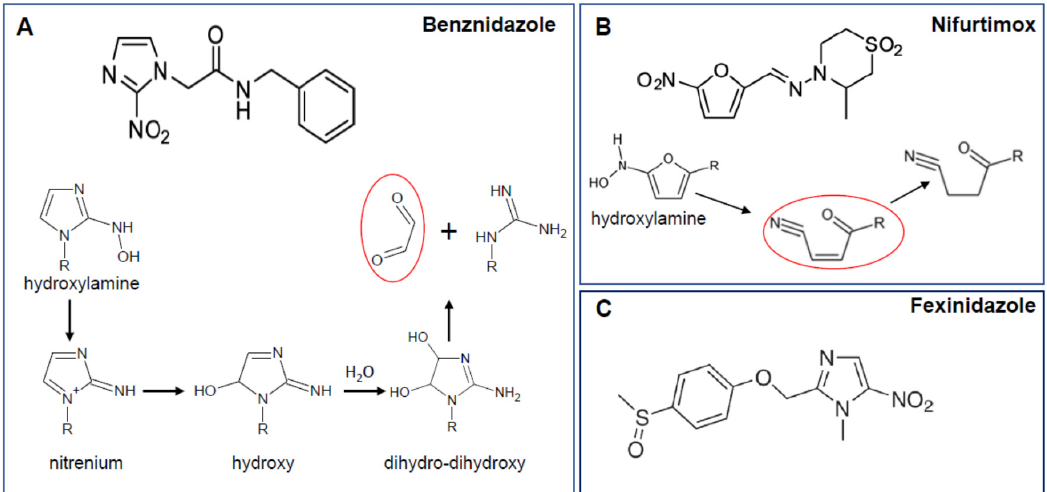
Figure 1. Nitroaromatic drugs used to treat Trypanosoma cruzi infections, or undergoing clinical trial. ( A ) Reductive metabolism of benznidazole, initiated by TcNTR-1, leads to the production of an unstable hydroxylamine derivative. This is readily converted to a hydroxy intermediate (possibly through a nitrenium ion form), which then reacts with water to generate a dihydro-dihydrooxy. This slowly breaks down to release the highly reactive dialdehyde, glyoxal (circled in red) [24]. The intermediaries and final product can form adducts with proteins, DNA, and small molecules such as glutathione and trypanothione. ( B ) Nifurtimox is reduced by TcNTR-1, leading to the generation of an unstable hydroxylamine. This decomposes, potentially via a ketoxime intermediate, to form unsaturated (circled in red) and then saturated open-chain nitriles [25]. The unsaturated form mediates trypanocidal activity. ( C ) Fexinidazole, an NTR-1-activated 5-nitroimidazole prodrug [31], has recently been approved as an oral treatment for African trypanosomiasis [32,33]. It outperforms other nitroaromatic drugs as a curative treatment for experimental T. cruzi infections [34], and is undergoing clinical trial against Chagas disease [35].